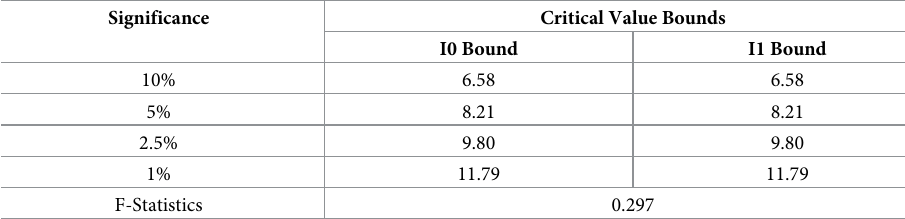
Table 9. Bound test result for cointegration.